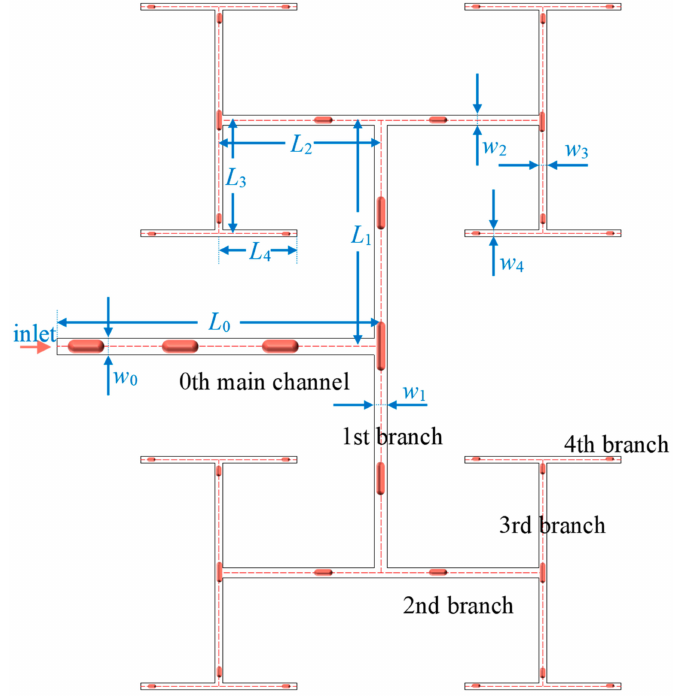
Figure 9. Tree-shaped